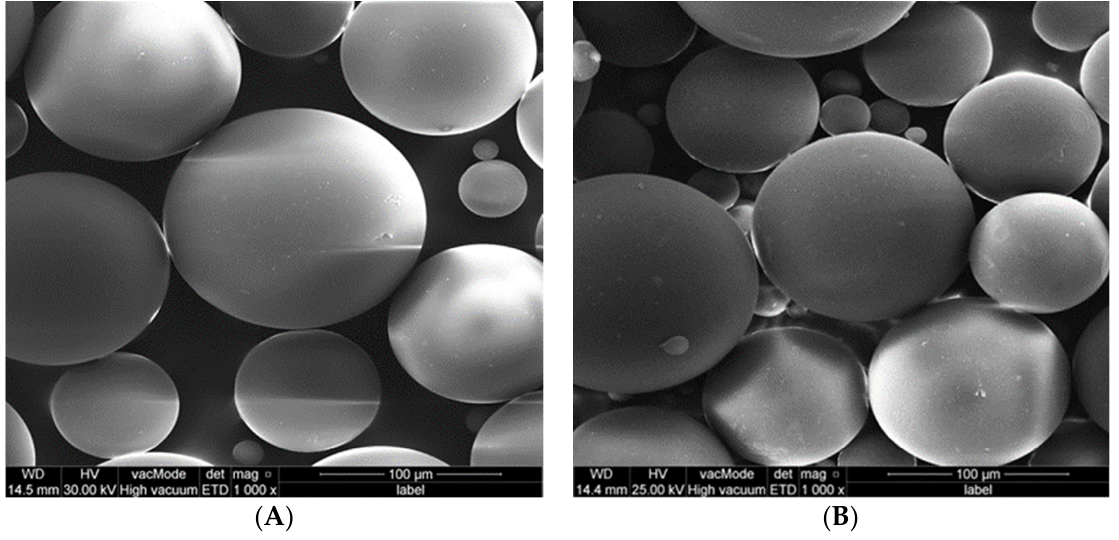
Figure 4. SEM for powder of control group, ( A ) PMMA powder alone; ( B ) PMMA powder with